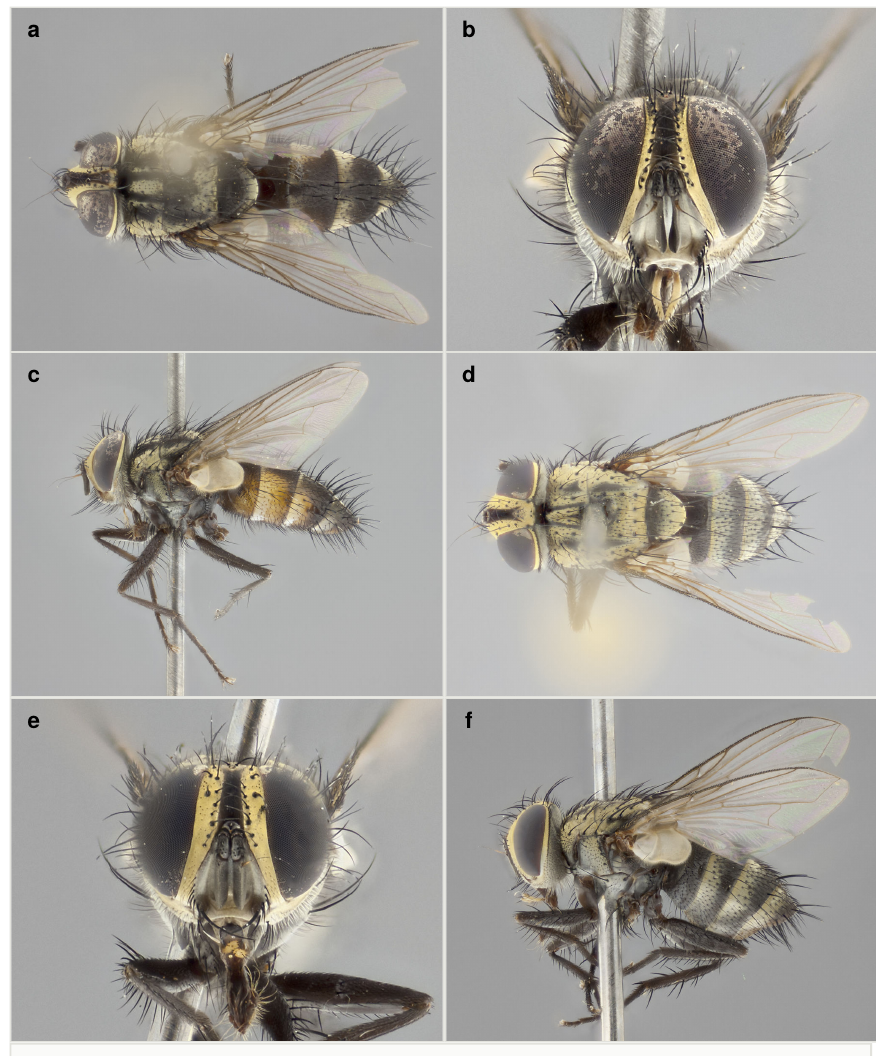
Vibrissina danmartini sp. n. a–c : holotype male, voucher code DHJPAR0017886; d–f : paratype female, voucher code